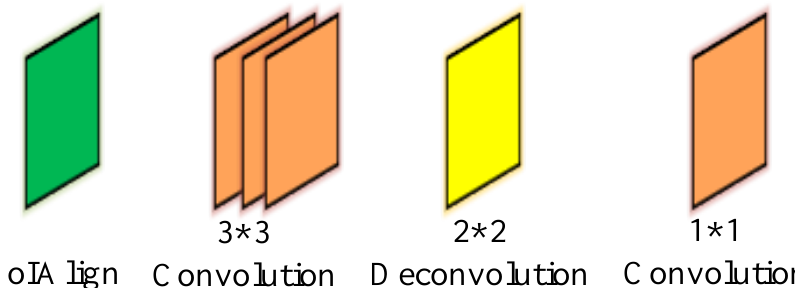
Figure 5. The structure of full convolutional network (FCN).